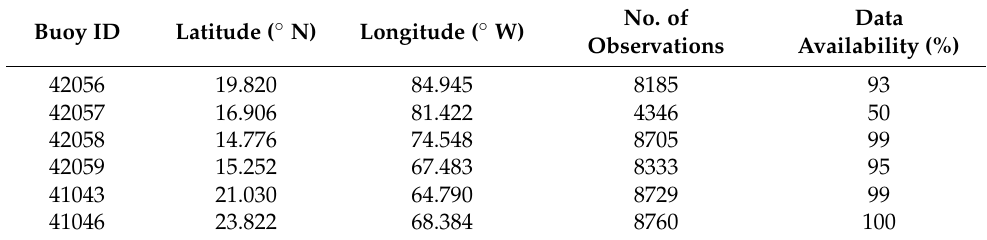
Figure 1. The model domain, Hurricane Matthew (2016) best track (red line), and topography (shading, m) with utilized NDBC buoy positions marked (red triangles). The dates at which Matthew passes the nearest buoys are also marked. Table 1. NDBC buoy data statistics for 2016.